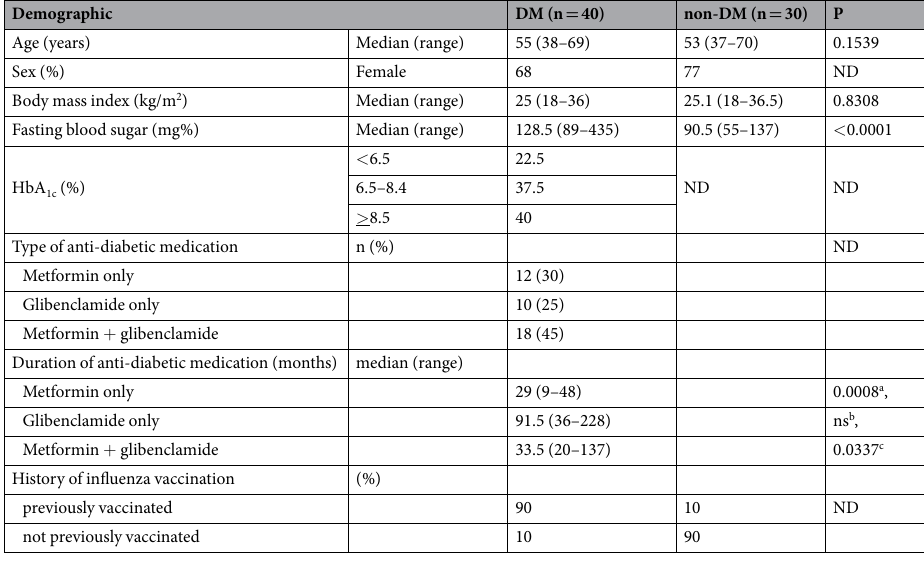
Table 1. Demographic characteristics of individuals participating in this study. DM: diabetes mellitus; ND: not determined; HbA 1c : glycated haemoglobin. Statistical analyses were undertaken using the unpaired t -test, ns: non-significant, a metformin vs . glibenclamide, b metformin vs . metformin + glibenclamide, c glibenclamide vs . metformin +